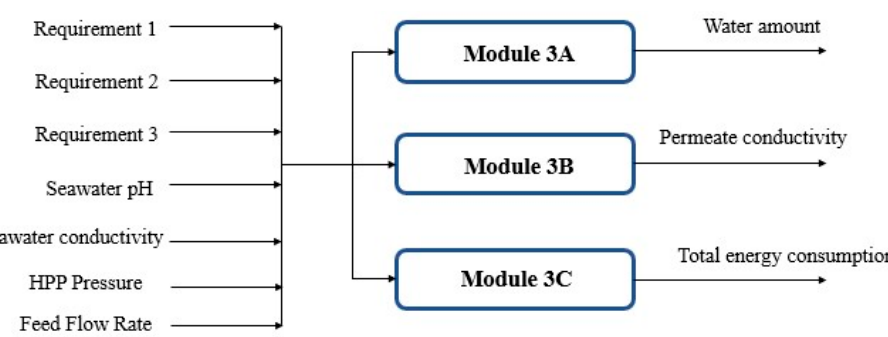
Figure 4. Block diagram of modules 3A, 3B and 3C of the system.